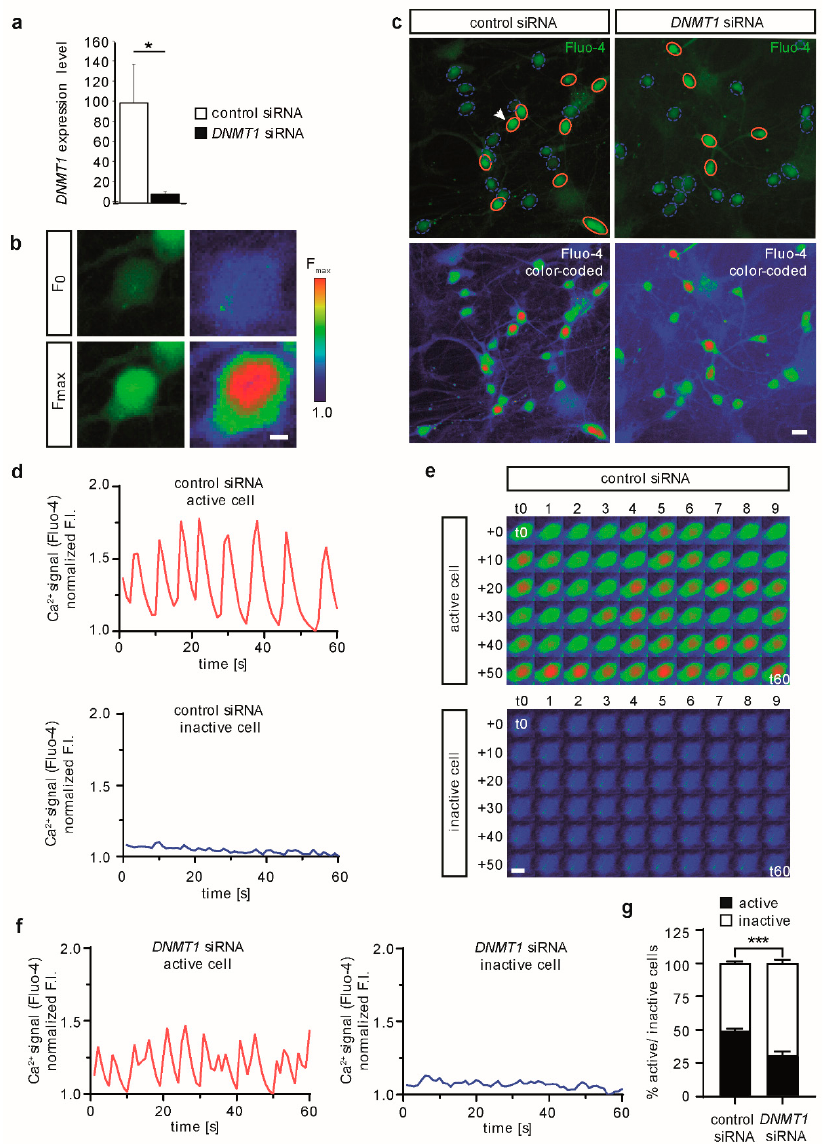
Figure 2. Spontaneous calcium oscillations are reduced in DNMT1 siRNA-treated human iPSC- derived neurons. Human iPSC-derived neurons (d14/d15) were transfected with control or DNMT1 siRNA for 24 h. Neurons were loaded with Ca 2+ -sensitive Fluo-4 dye and subsequently used for live-cell imaging of spontaneous calcium oscillations. ( a ) Validation of DNMT1 downregulation via DNMT1 siRNA. Expression levels of HEK293T cells 24 h after siRNA transfection were assessed by qPCR, using RPS18 as housekeeping gene for normalization. Bar graphs indicate mean DNMT1 expression levels ± standard errors; two-tailed Student’s t -test, * = p < 0.05. ( b ) Representative images of the Fluo-4 fluorescence as recorded during imaging (left images) and visualized via pseudo-coloring (right images) of an oscillating cell in its inactive state (low calcium levels, upper row) and active state (high calcium levels, lower images). F 0 = minimum fluorescence, F max = maximum fluorescence; scale bar = 5 µ m. ( c ) Overview image depicting a single frame of a random example of neurons transfected as indicated (left panels: control siRNA; right panels: DNMT1 siRNA). Upper panels show fluorescence intensity (FI) of Fluo-4 (green color), active cells are circled in red, inactive cells are circled with blue dashed lines (white arrow points at cell magnified in ( b )). Lower panels show the same images but with pseudo-colored fluorescence intensity similar as in ( a